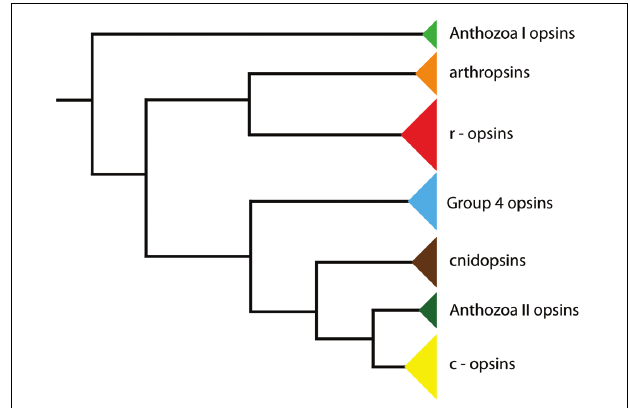
FIGURE 1 | Phylogeny of opsin genes. The tree illustrates the position of arthropsins as the sister group of r-opsins, including melanopsins (phylogenetic relationships according to Hering and Mayer,